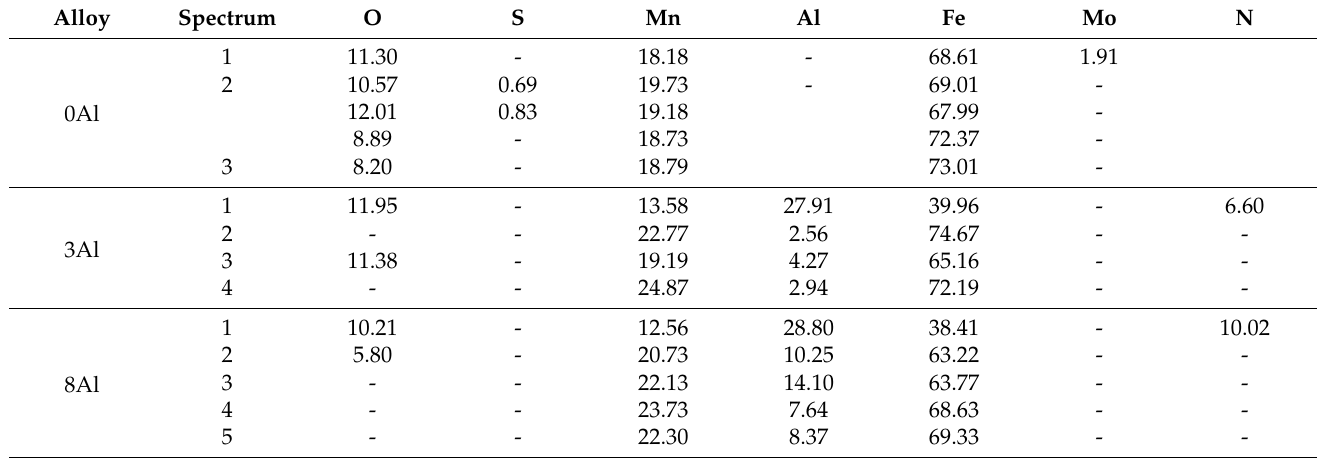
Table 3. EDS composition (wt.%) corresponding to the surfaces of the alloys shown in Figure 4. Alloy